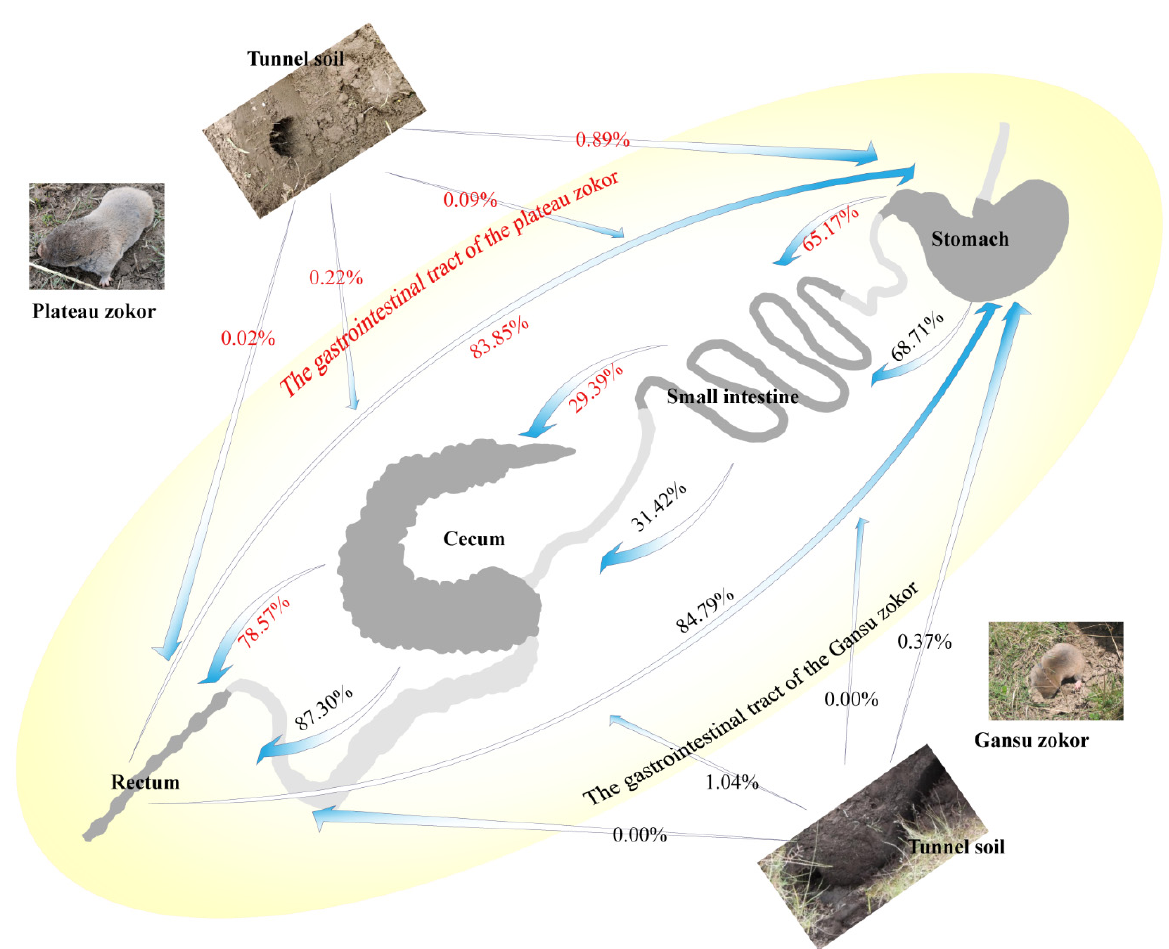
Figure 5. Fast expectation–maximization microbial source tracking (FEAST) analysis. Percentages for the plateau zokor are shown in red, and percentages for the Gansu zokor are shown in black. The values one near to the arrows are the percentages of the microbiota contributed by the GIT segment behind the arrow to the GIT segment in front of the arrow.